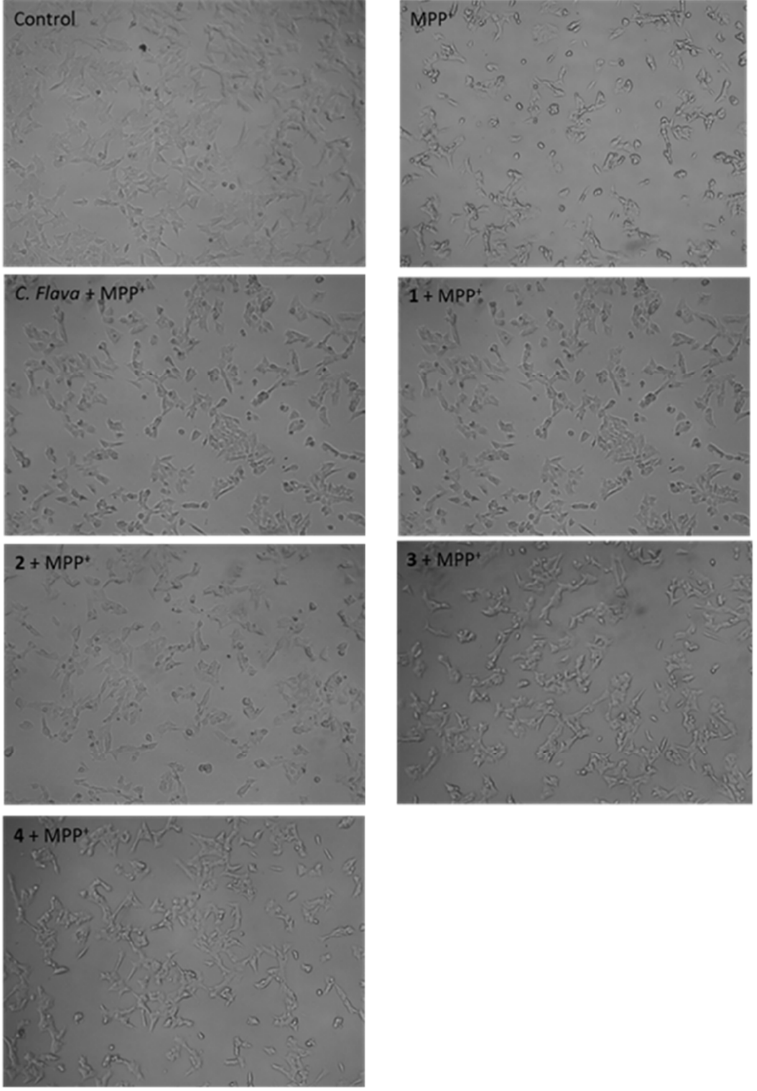
Figure 4. Crossyne flava inhibited SH-SY5Y morphological changes induced by MPP + . SH-SY5Y cells were pre-treated with total extract and compounds at the 2.5 µ g/mL before exposure to 2000 µ M MPP + for 24 h. Cells were visualized, and images were acquired using the light microscope at 100 ×